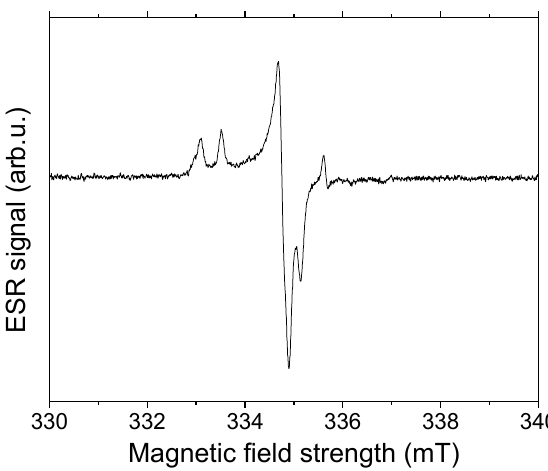
Figure 10. ESR spectrum of fresh celestine packing.